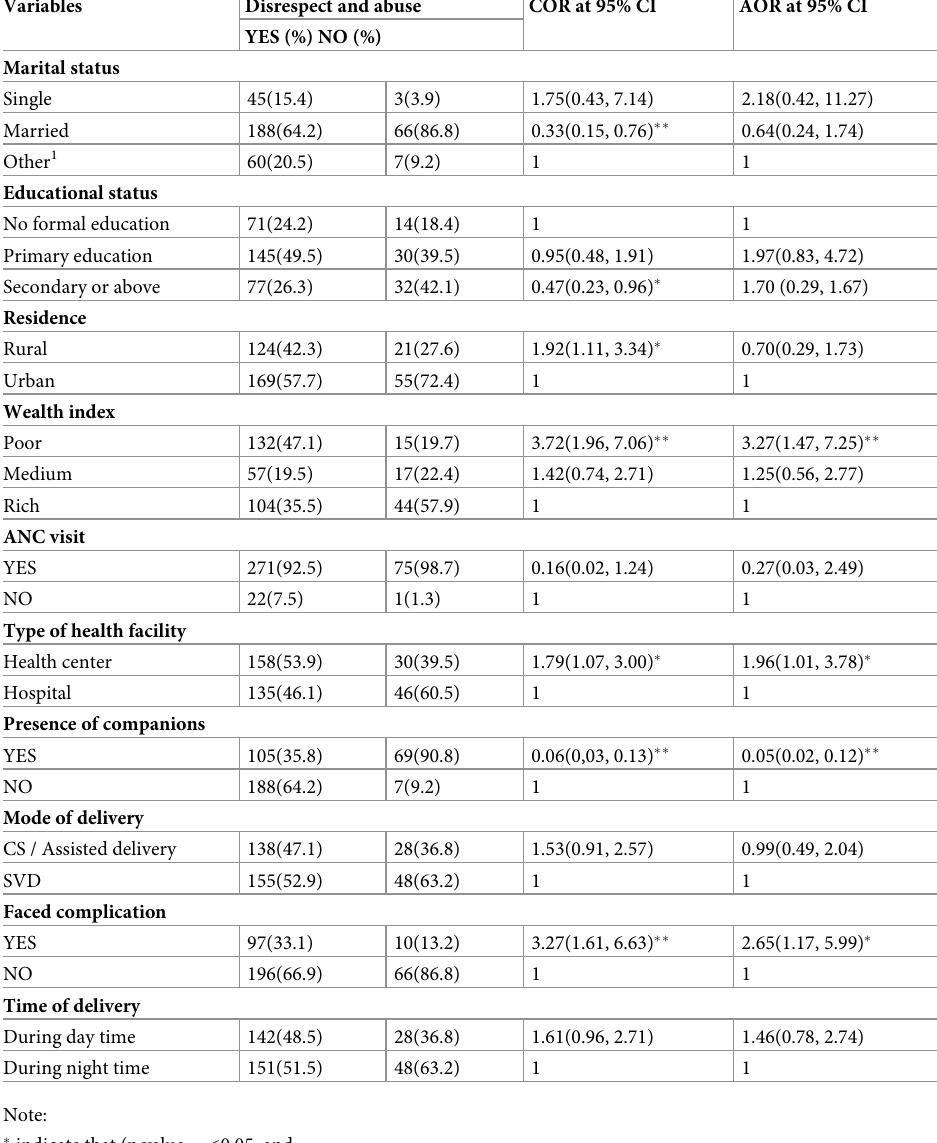
Table 4. Factors associated with disrespect and abuse among women who delivered in public health facilities of Borena District, Amhara region, Ethiopia, 2020 (n = 369).